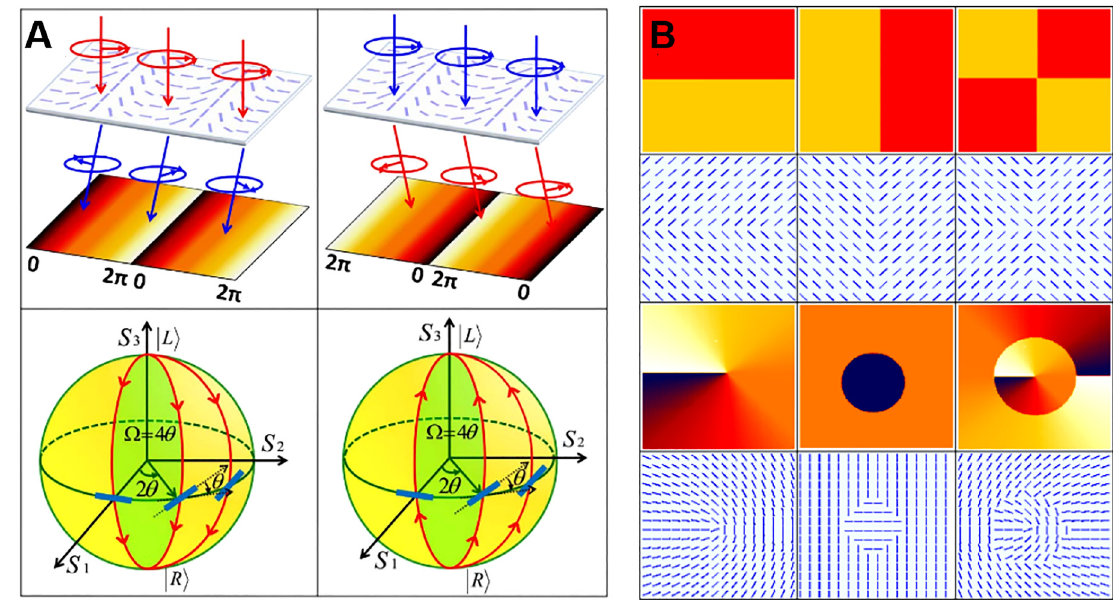
Figure 3: Illustration of the polarization evolutions on Poincaré sphere and the PB phases included [73]. (A)TheinducedPBphasevariesperiodicallywiththerotationofopticalaxes,andthisvariationisintheoppositedirectionswhenleft-orright- circularly polarized light passes through the metasurface. The red and blue arrows indicate left- and right-circularly polarized lights. The incident light gets a 2 θ phase, which is double the orientation angle of the optical axis (slow) and half of the solid angle enclosed by the polarization evolving routes. (B) By controlling the local orientation of the optical axis, any desired phase can be